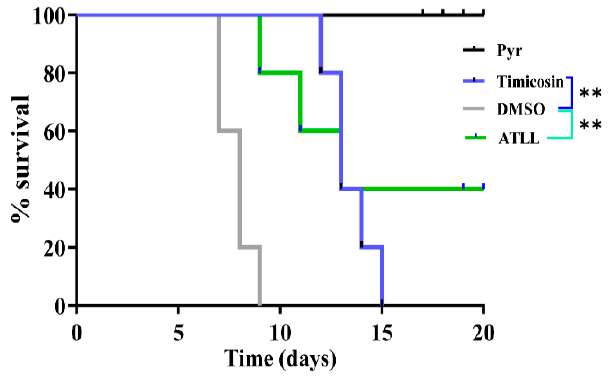
Figure 8. Treatment effects of Tilmicosin and ATLL on acute T. gondii infection in mice. Female BALB/c mice (n = 5) were intraperitoneally infected with 500 parasites (type I RH strain). Mice were then treated with intraperitoneal injections of tilmicosin (100 mg/kg/day), ATLL (100 mg/kg/day), pyrimethamine (15 mg/kg/day), or DMSO. The survival of mice was monitored daily. ** p <